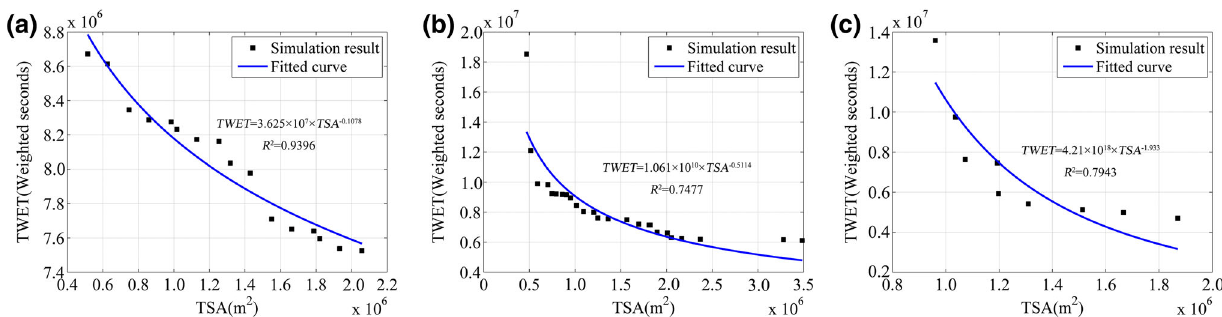
Fig. 3 Relationships between total weighted evacuation time (TWET) and total shelter area (TSA) with current evacuation population and different community locations. a Location 1, the